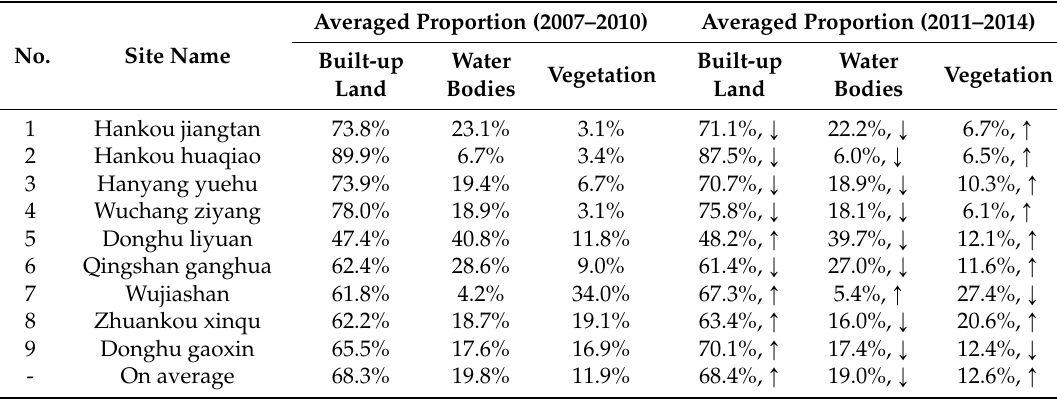
Table 2. Proportion of land use categories of each monitoring site within 4-km